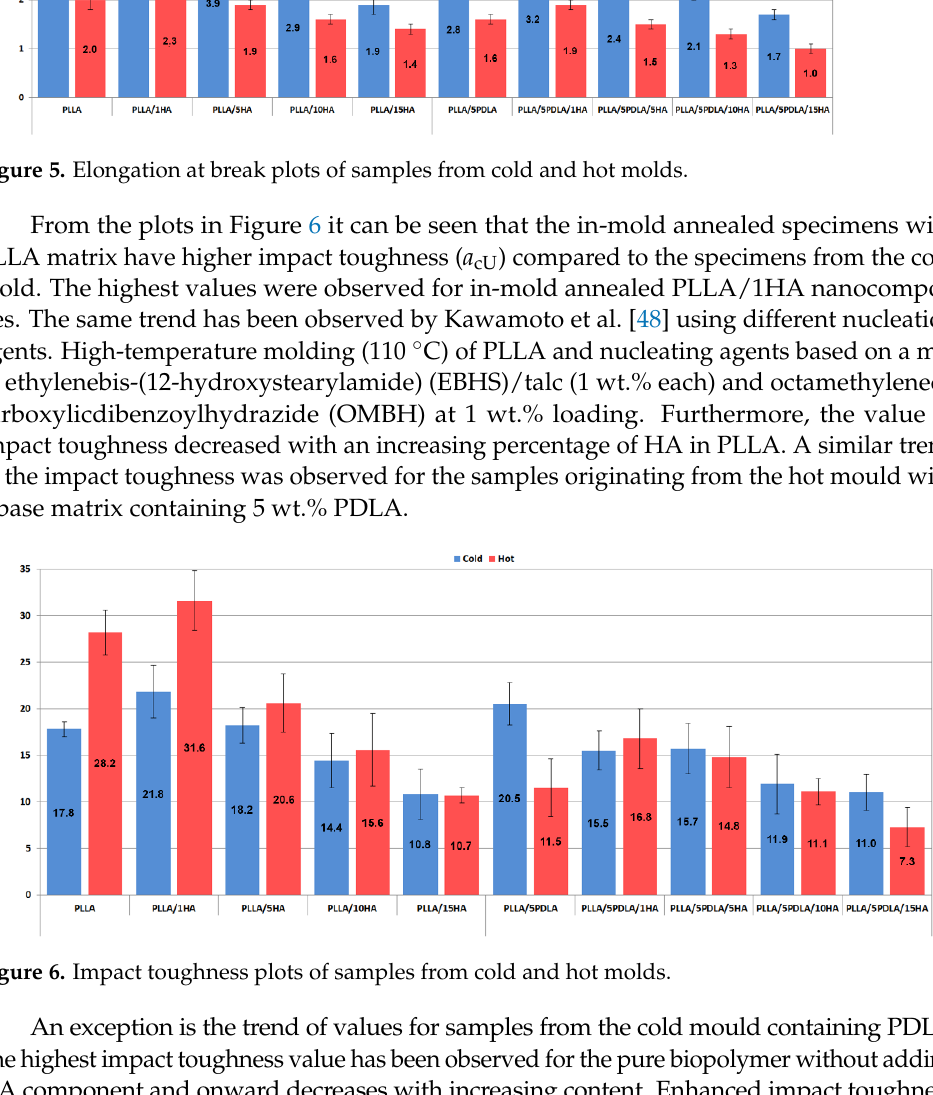
Figure 5. Elongation at break plots of samples from cold and hot molds.